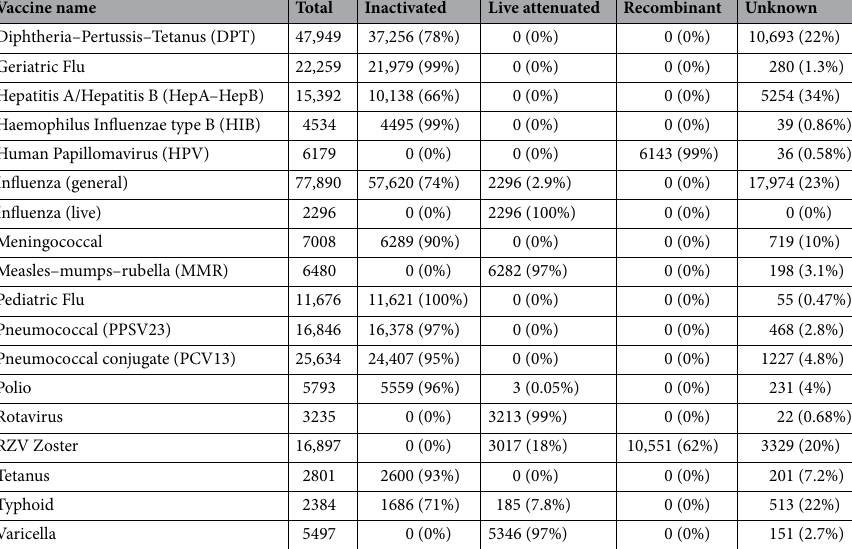
Table 3. Patient counts by vaccination type. Breakdown of patient counts by vaccine type for each of the 18 vaccines taken by at least 1000 individuals within 5 years prior to their PCR test date. In particular, counts and percentages are shown for the following vaccine types: (1) Inactivated, (2) Live attenuated, (3) Recombinant, and (4)